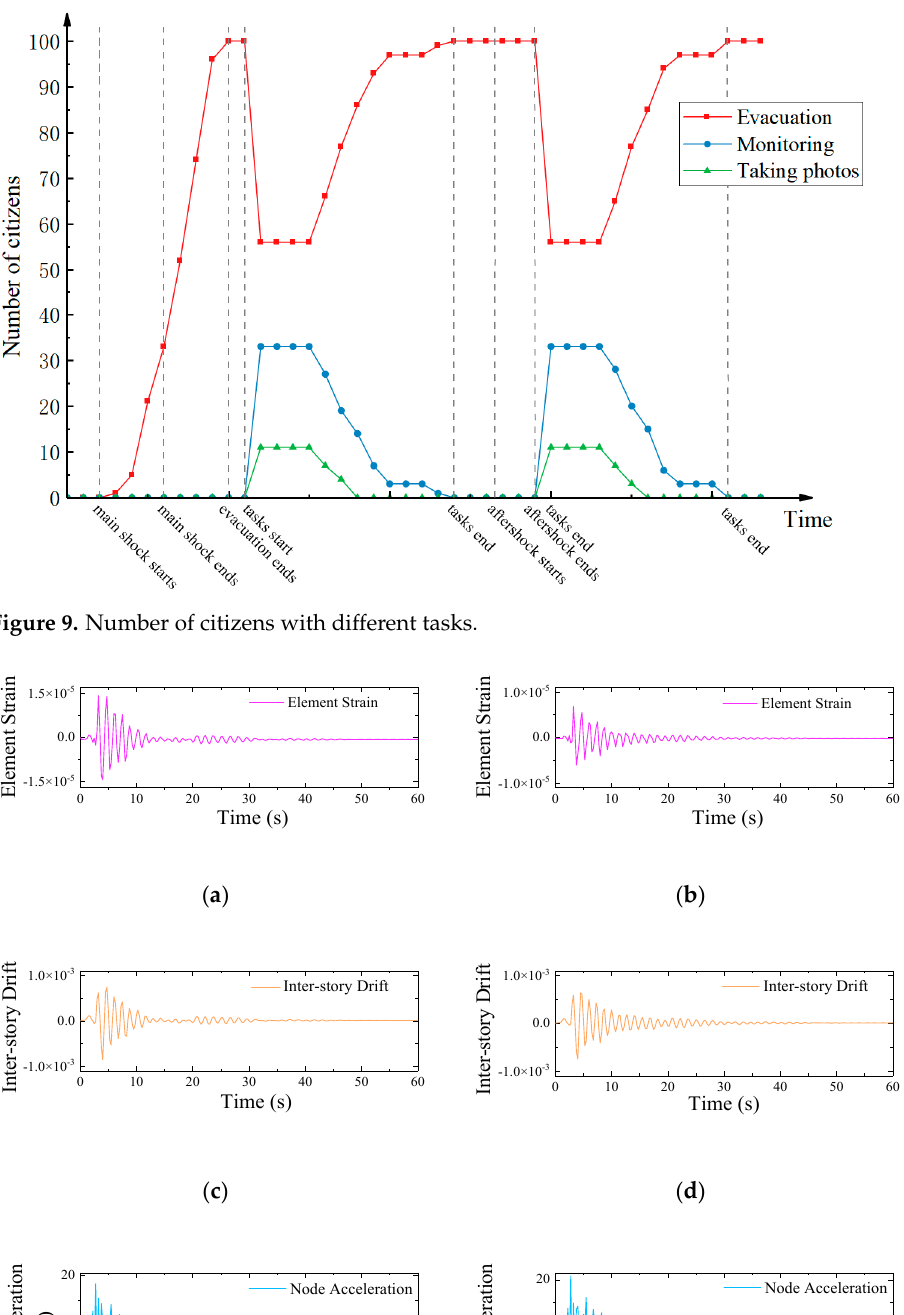
Table 4. Response values that are assumed to be measured by citizens.